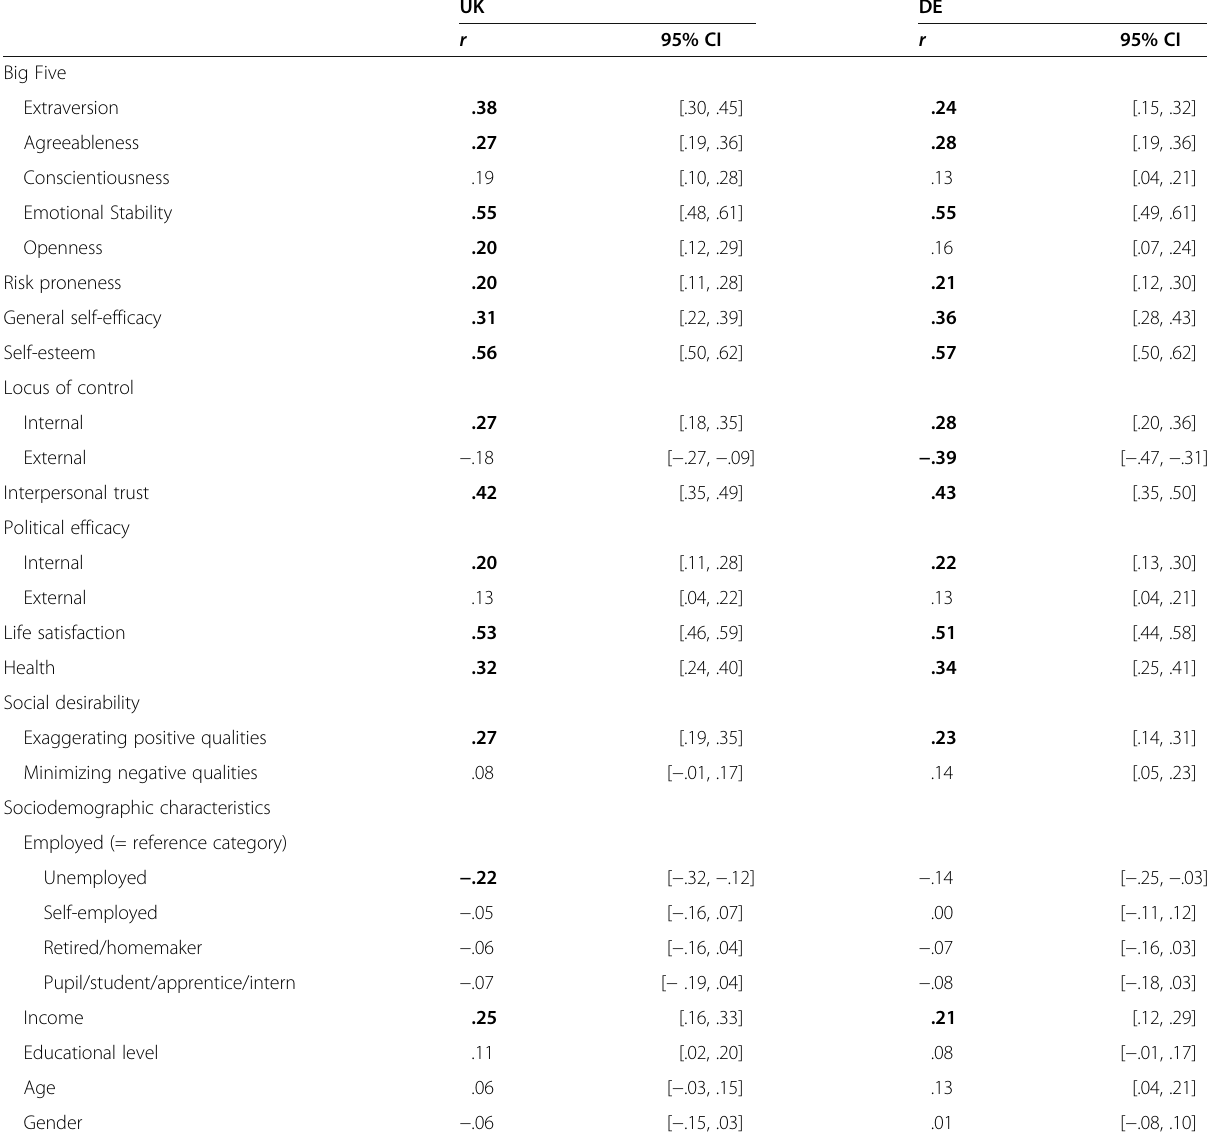
Table 5 Correlations of SOP2 with validation measures and sociodemographic characteristics, by nation